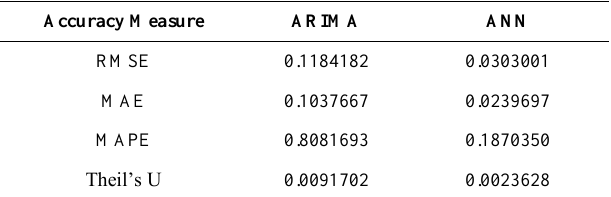
Table 6. The forecast accuracy measures for selected ARIMA and ANN model